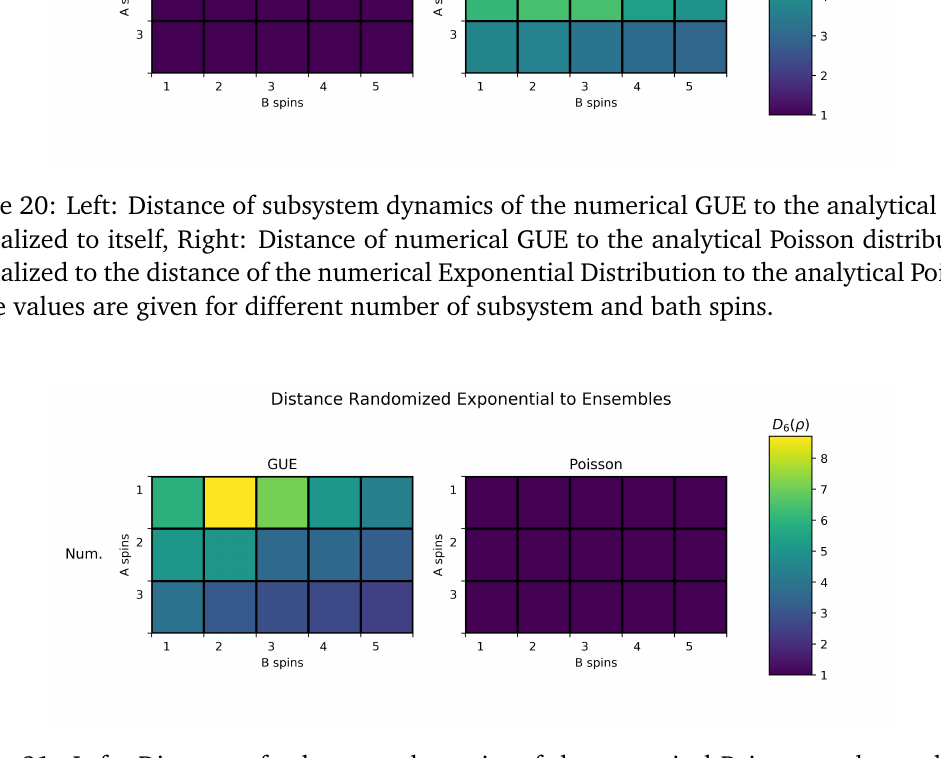
Figure 21: Left: Distance of subsystem dynamics of the numerical Poisson to the analytical GUE, normalized to the distance of the numerical GUE to the analytical GUE. Right: Distance of numerical Poisson to the analytical Poisson, normalized to itself. These values are given for different number of subsystem and bath